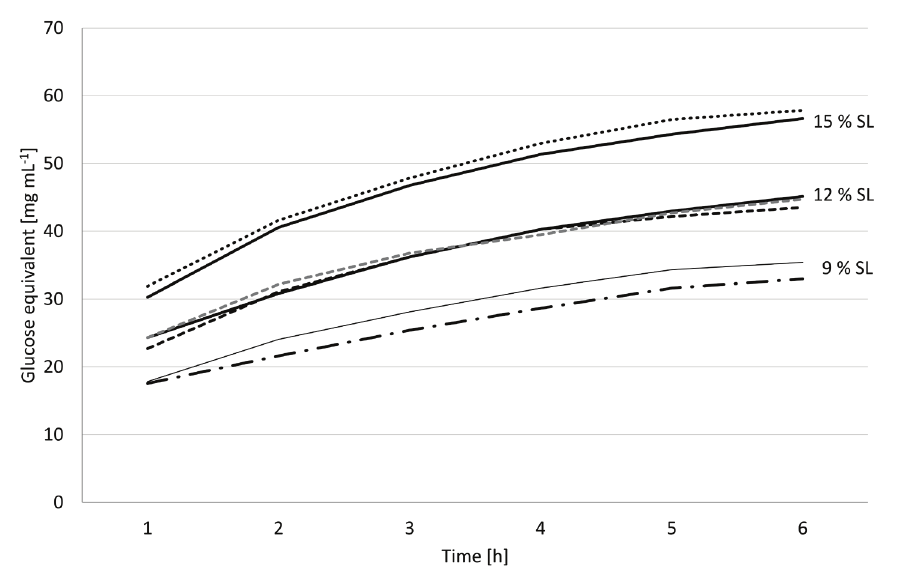
Fig. 8 – Glucose concentration at various solid loadings; 9, 12, 15 % α-cellulose (α-cellulose, 10 mm amplitude, 2 mm baffle, 10 FPU, 50 °C, 6